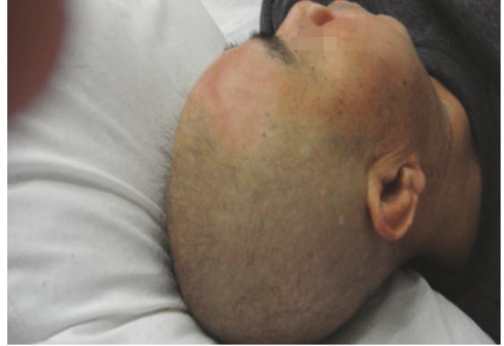
Figure 2: All hair loss (February 26, 2014).